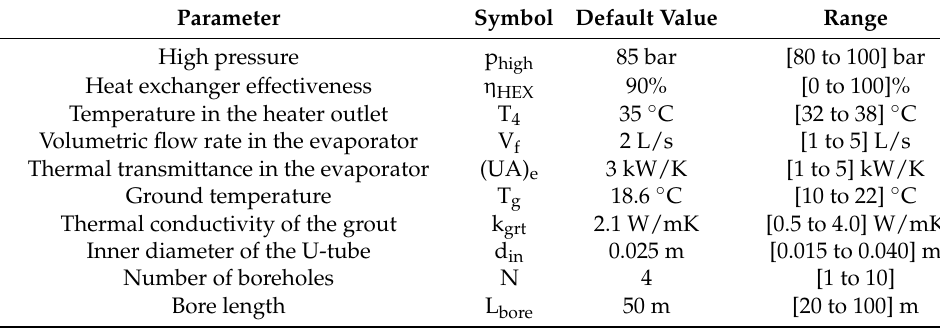
Table 1. Parameters of the parametric analysis. Parameter Symbol Default Value Range High pressure p